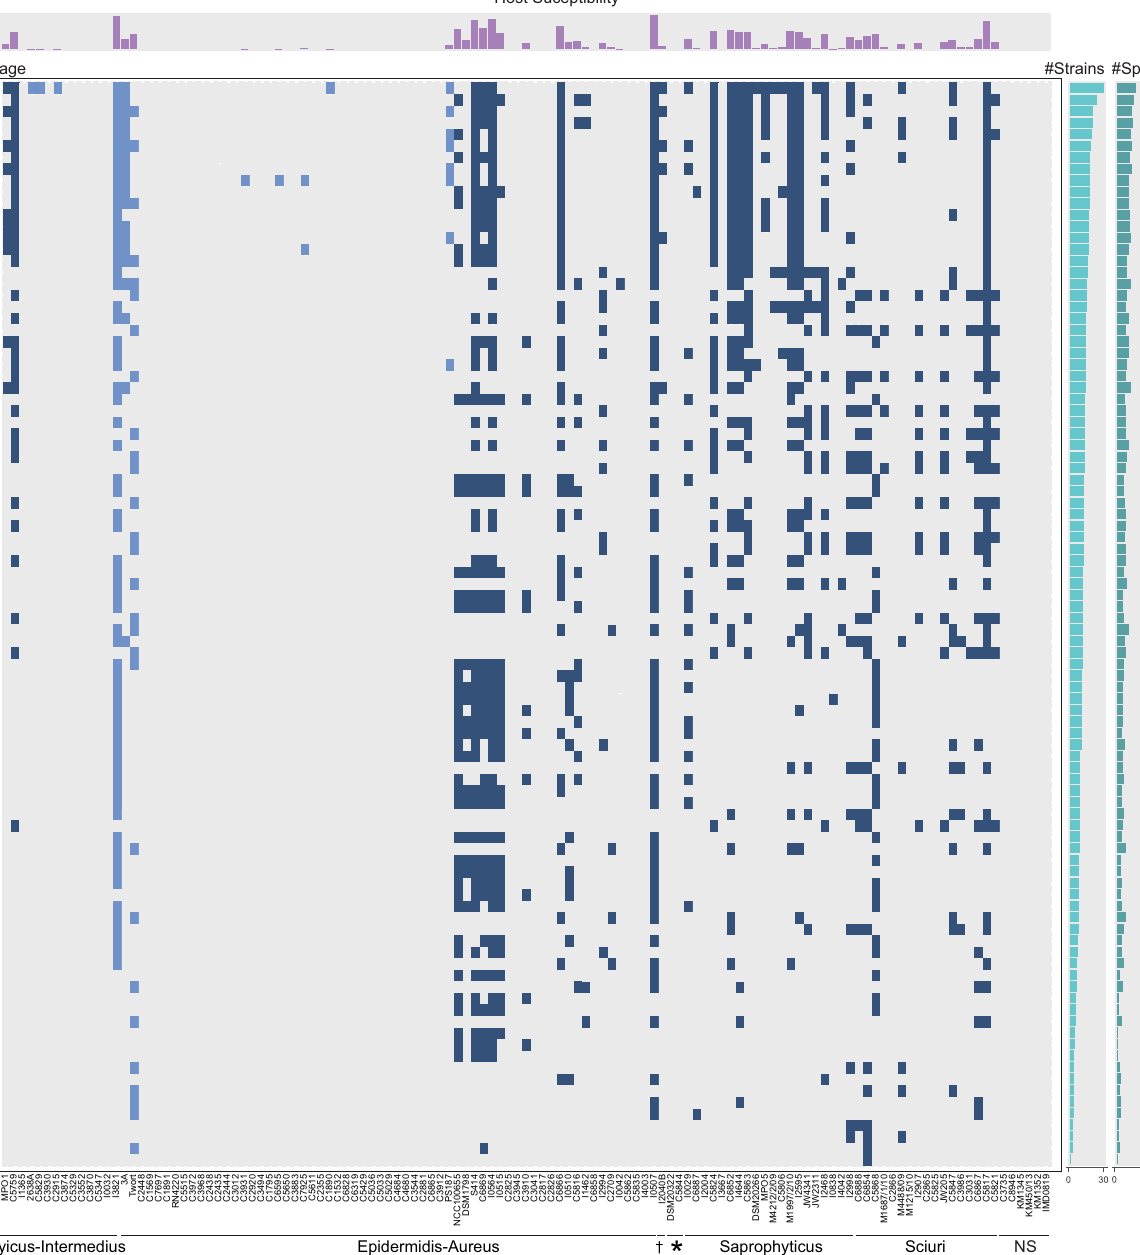
from 3.4 ± 0.9 ( n = 94) different species groups and six phages replicated on fi ve out of the six possible groups.